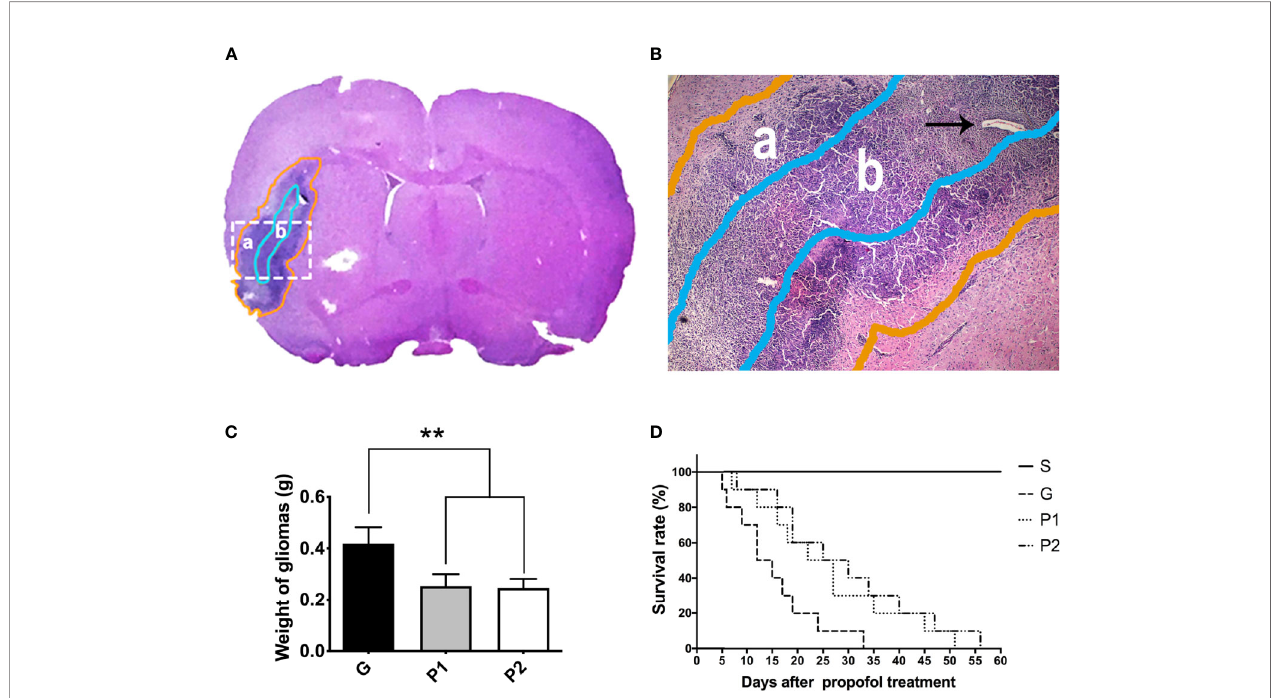
FIGURE 1 | Shape of rat C6 glioma was revealed by whole-brain slice H&E staining, and 60-day survival curve was analyzed. (A, B) The shape of the glioma (a, gold circle) and tumor core (b, light blue circle) is shown using H&E staining of a tumor tissue coronal slice. Glioma cells and vascular arrangement (arrowhead) observed using optical microscopy (magni fi cation, ×40). (C) On day 18 after establishing the C6 glioma model, the gliomas were removed from the rats and the weight of the fresh tumors was measured. Data are presented as the mean ± standard deviation (n=6/group). (D) The 60-day survival rate was investigated every day after propofol treatment (n=10/group). **P < 0.01. Groups: G, glioma; P1 and P2, propofol 20, and 40 mg/kg -1 /h -1 , respectively. H&E, hematoxylin and